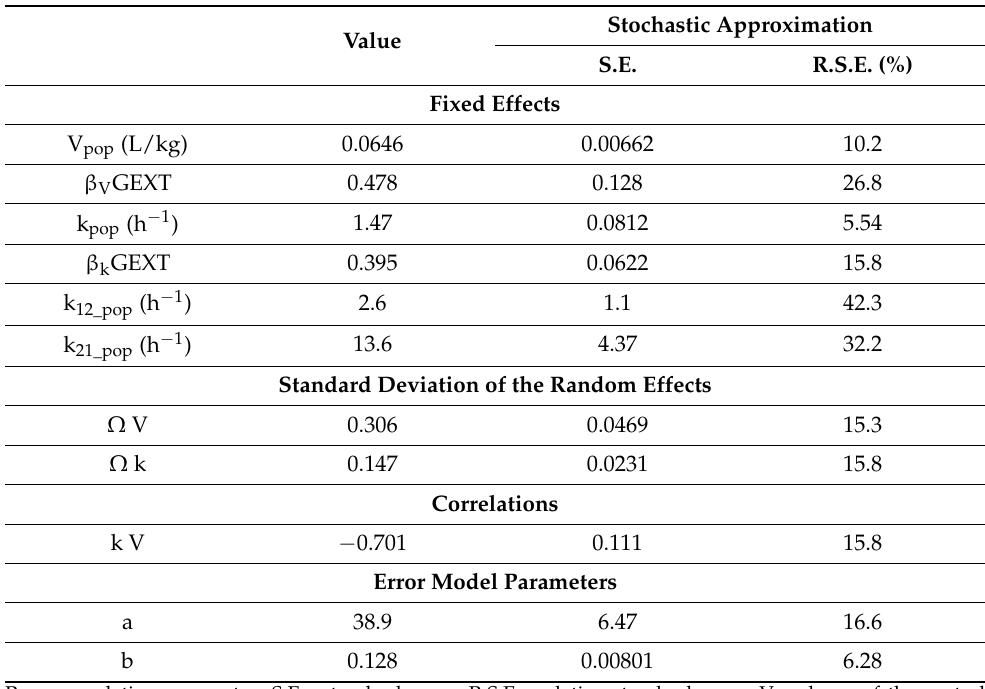
Table 4. Population pharmacokinetic parameters of rutin after intravenous administration of pure rutin and from the extract from Physalis peruviana